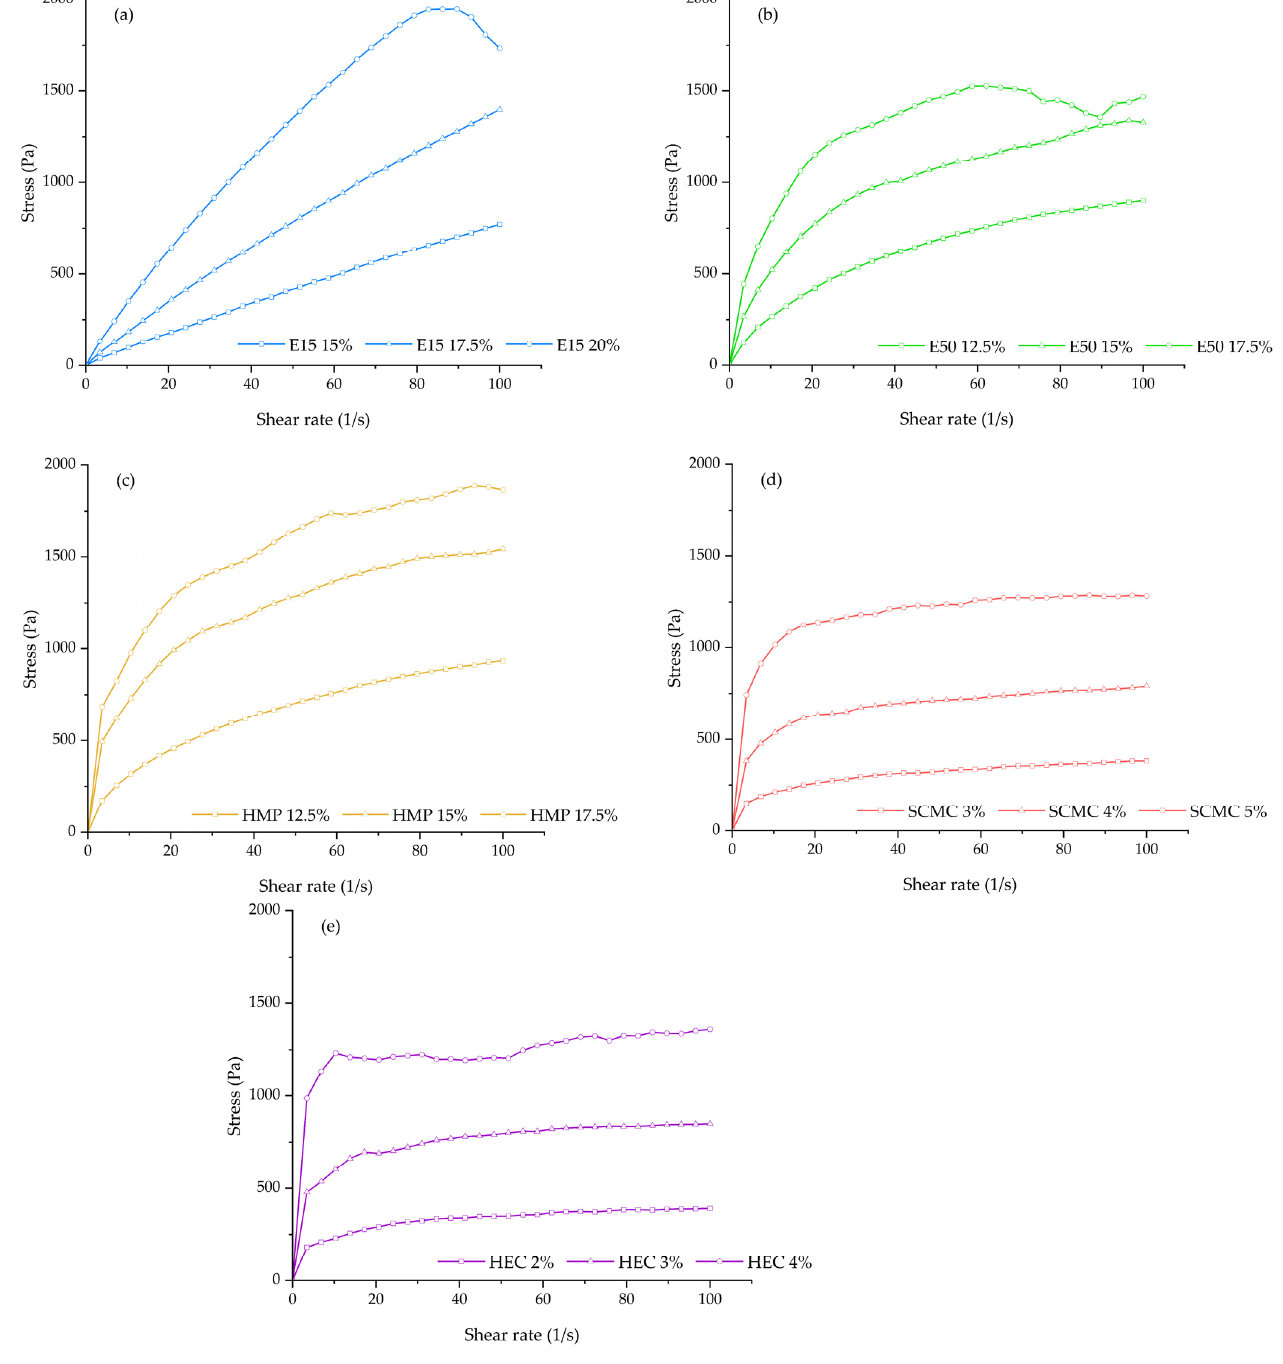
Figure 2. Rheogram of ( a ) HPMC E15 printing gels at concentrations of 15, 17.5, 20% w / v ; ( b ) HPMC E50 printing gels at concentrations of 12.5, 15, 17.5% w / v ; ( c ) HMP printing gels at concentrations of 12.5, 15, and 17.5% w / v ; ( d ) SCMC printing gels at concentrations of 3, 4, and 5% w / v ; and ( e ) HEC printing gels at concentrations of 2, 3, 4% w / v .